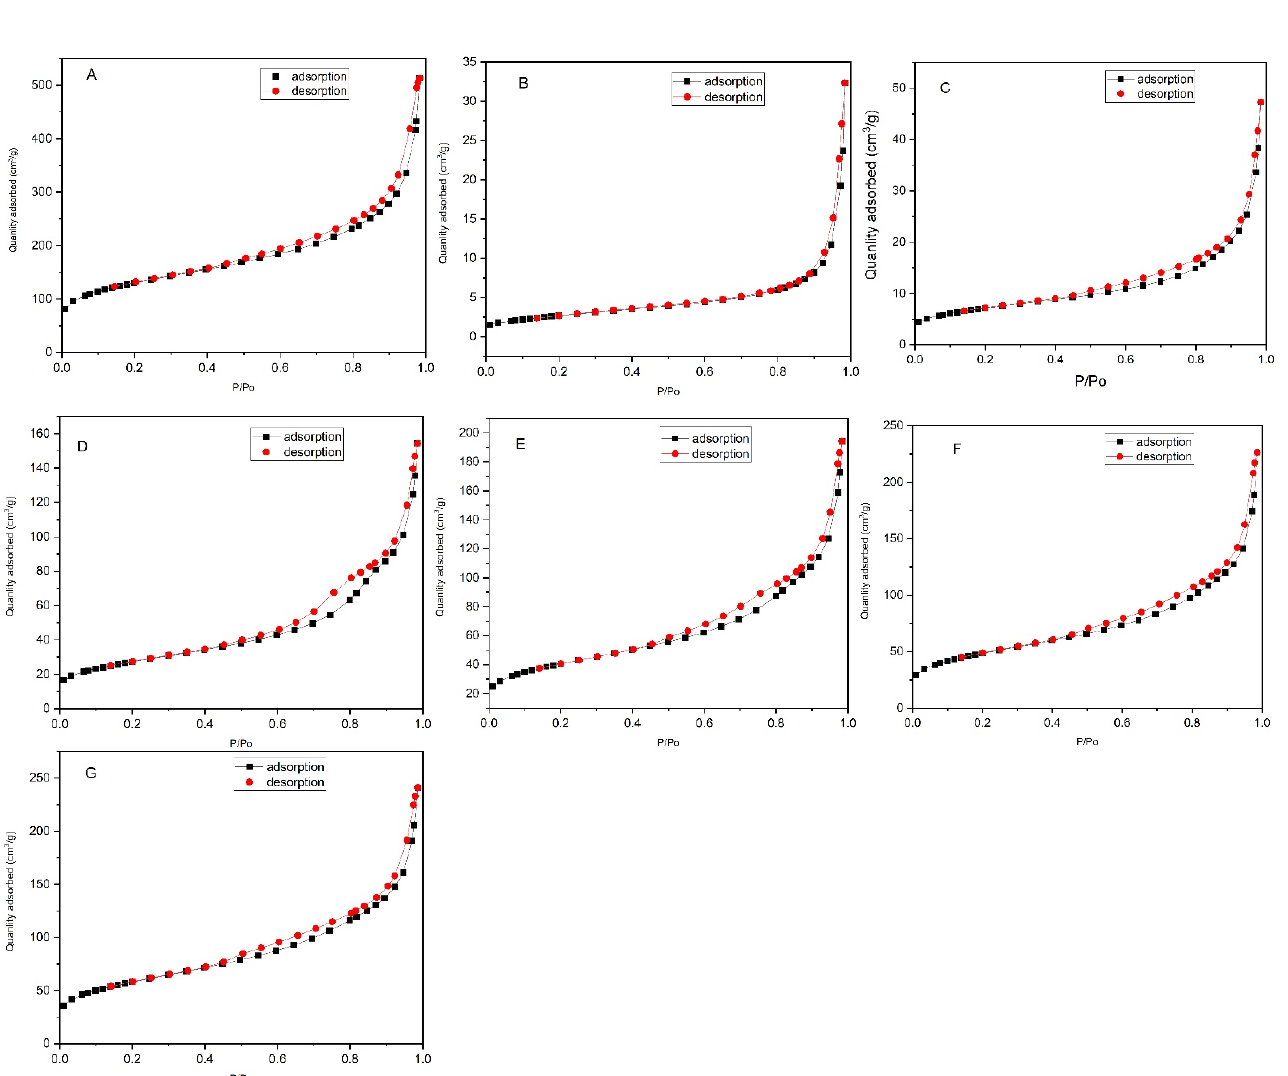
Figure 4. Nitrogen adsorption–desorption isotherm curves for ( A ) SiO 2 , ( B ) TiO 2 , ( C ) T/S 5%, ( D ) T/S Table 2. Effect of silica on the specific surface area (S BET ) of materials compared to pure TiO 2 . Samples